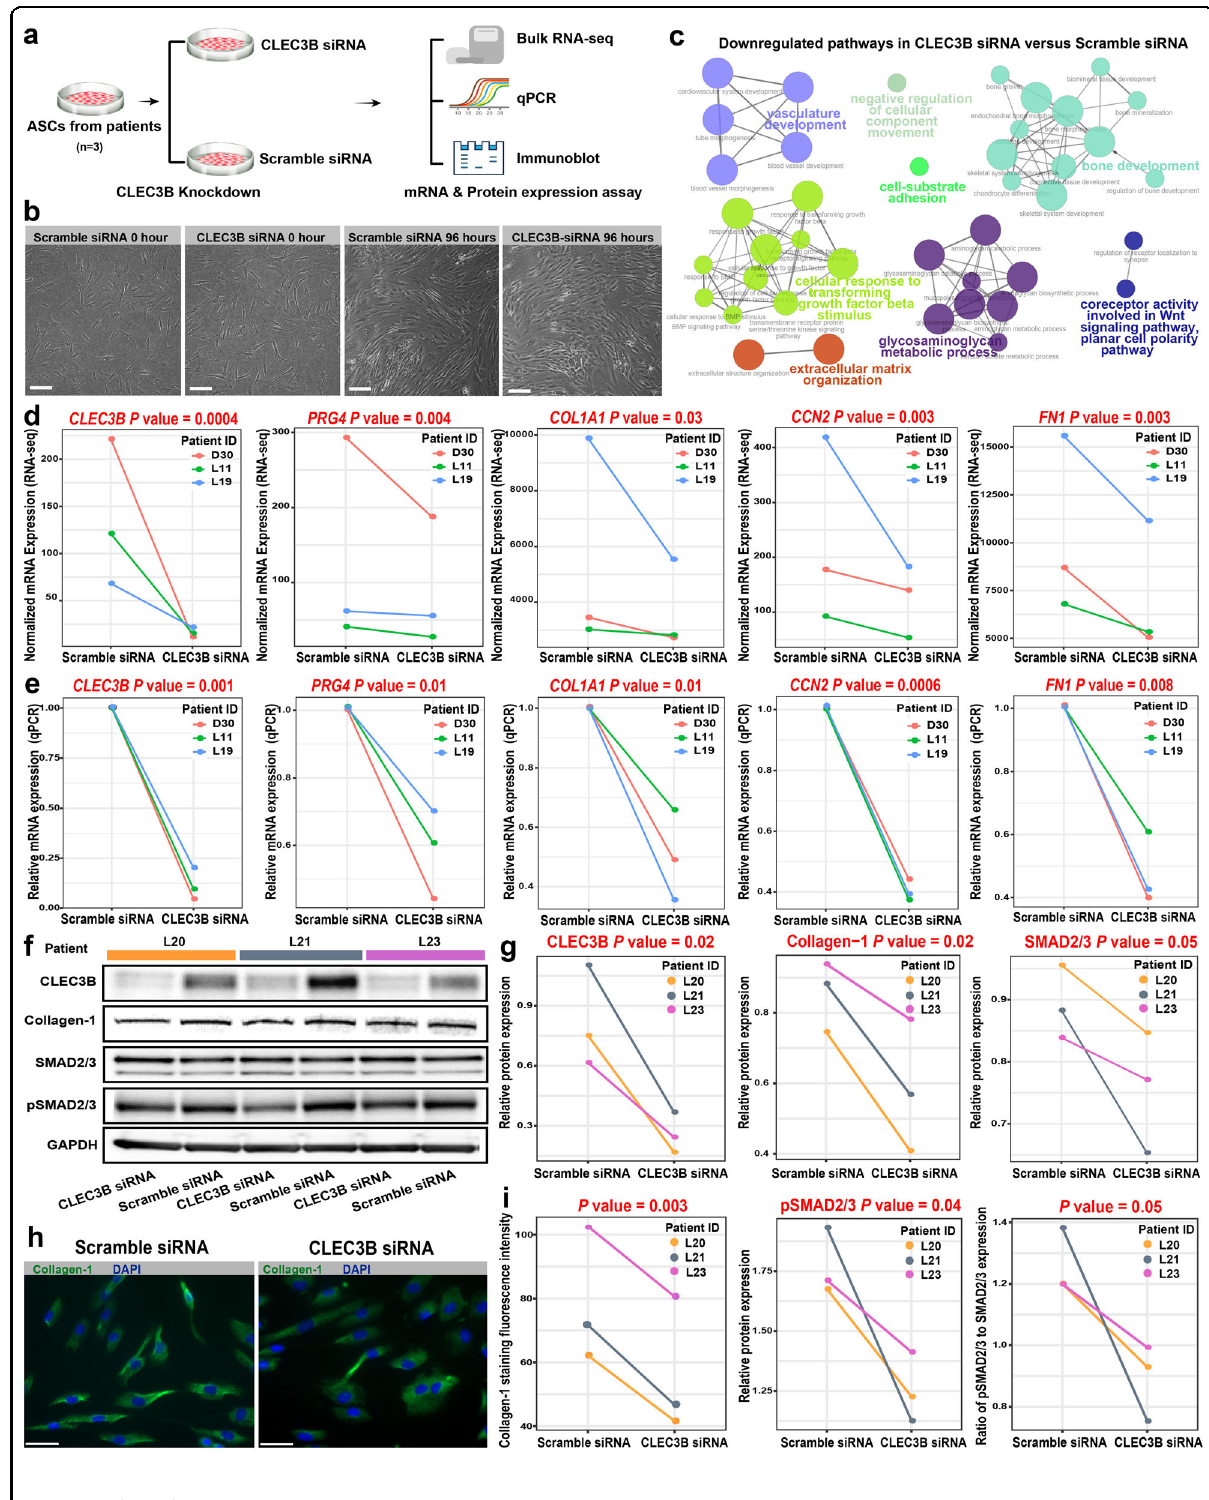
Fig. 5 (See legend on next